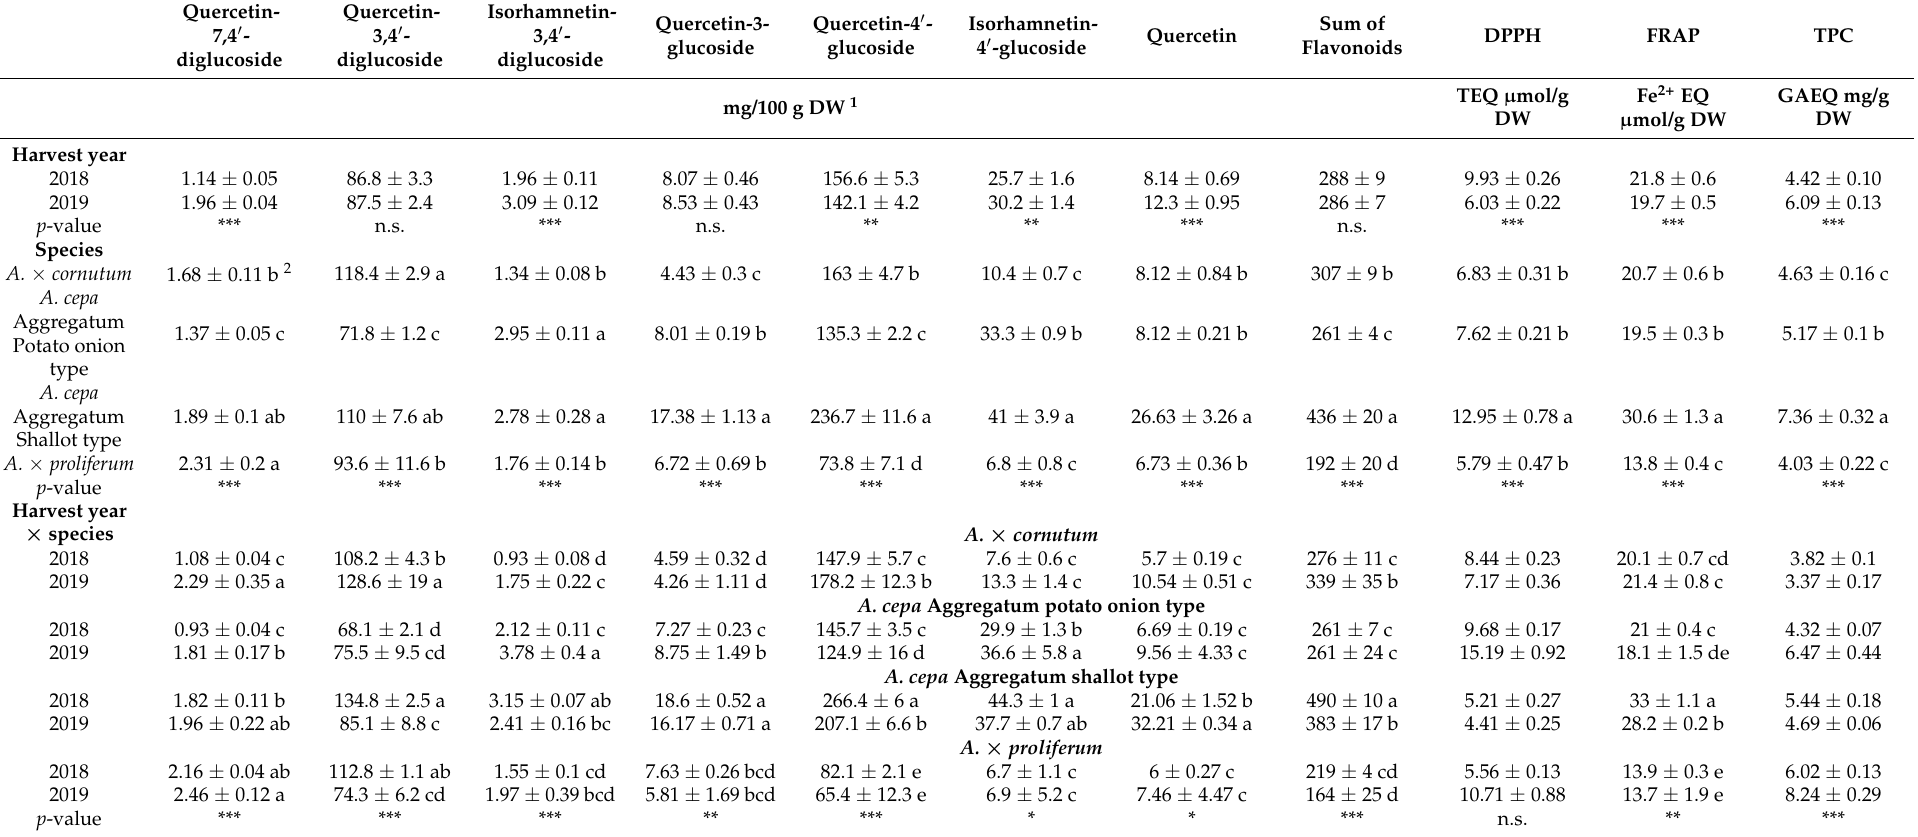
Table 2. Flavonoid compounds, total phenolic content and antioxidant capacity, measured by FRAP and DPPH radical scavenging in shallots by harvest year and species, their interaction and individual